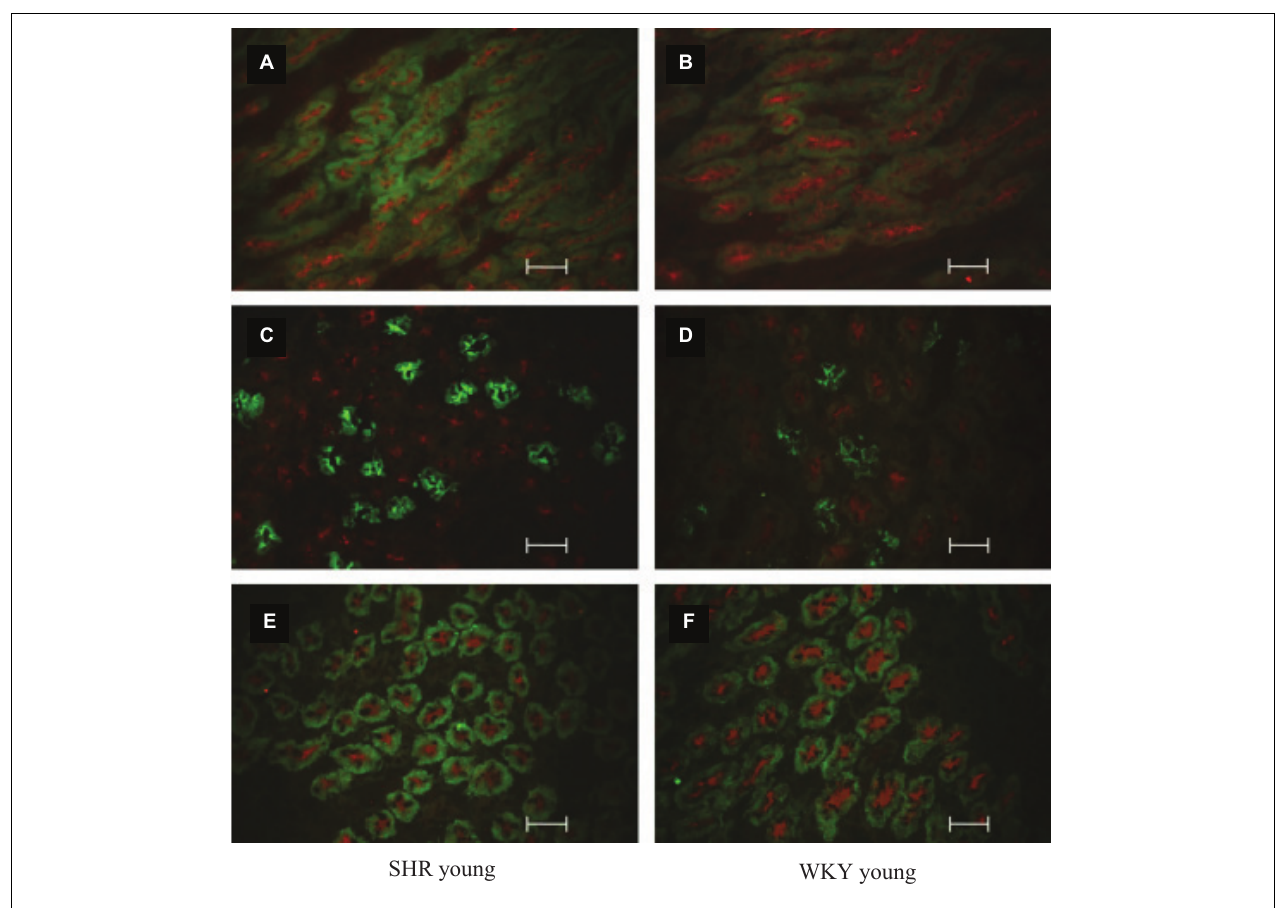
FIGURE 3 | Co-immunostaining and localization of BGT-1, Uromodulin-Tamm-Horsfall, AQP2, and alpha-1-Na-K ATPase in the renal medulla of prehypertensive young female SHR vs. age-matched WKY by indirect immunostaining reaction in cryosection. Tubule BGT-1 and Uromodulin-Tamm-Horsfall co-immunostaining in prehypertensive SHR (A) vs. age-matched WKY (B) . Tubule AQP2 and Uromodulin-Tamm-Horsfall co-immunostaining in prehypertensive SHR (C) vs. age-matched WKY (D) . Tubule alpha-1-Na-K ATPase and Uromodulin-Tamm-Horsfall co-immunostaining in prehypertensive SHR (E) vs. age-matched WKY (F) . Unit: 50 µ